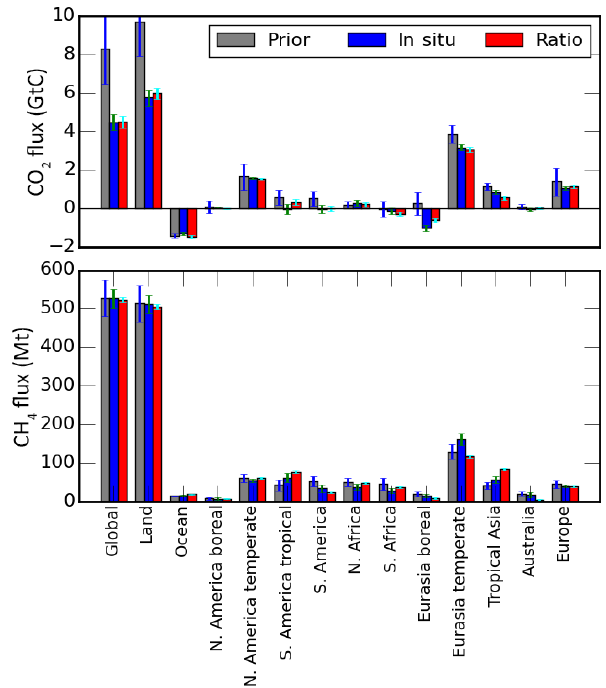
Figure 2. Annual mean (2010–2014, inclusive) regional net fluxes of (top) CO 2 and (bottom) CH 4 inferred from the (red) ratio exper- iments and the (blue) in situ experiments. The grey columns rep- resent the a priori estimates and the vertical lines superimposed on the columns denote 1 σ error. Geographical regions are as defined in Fig.